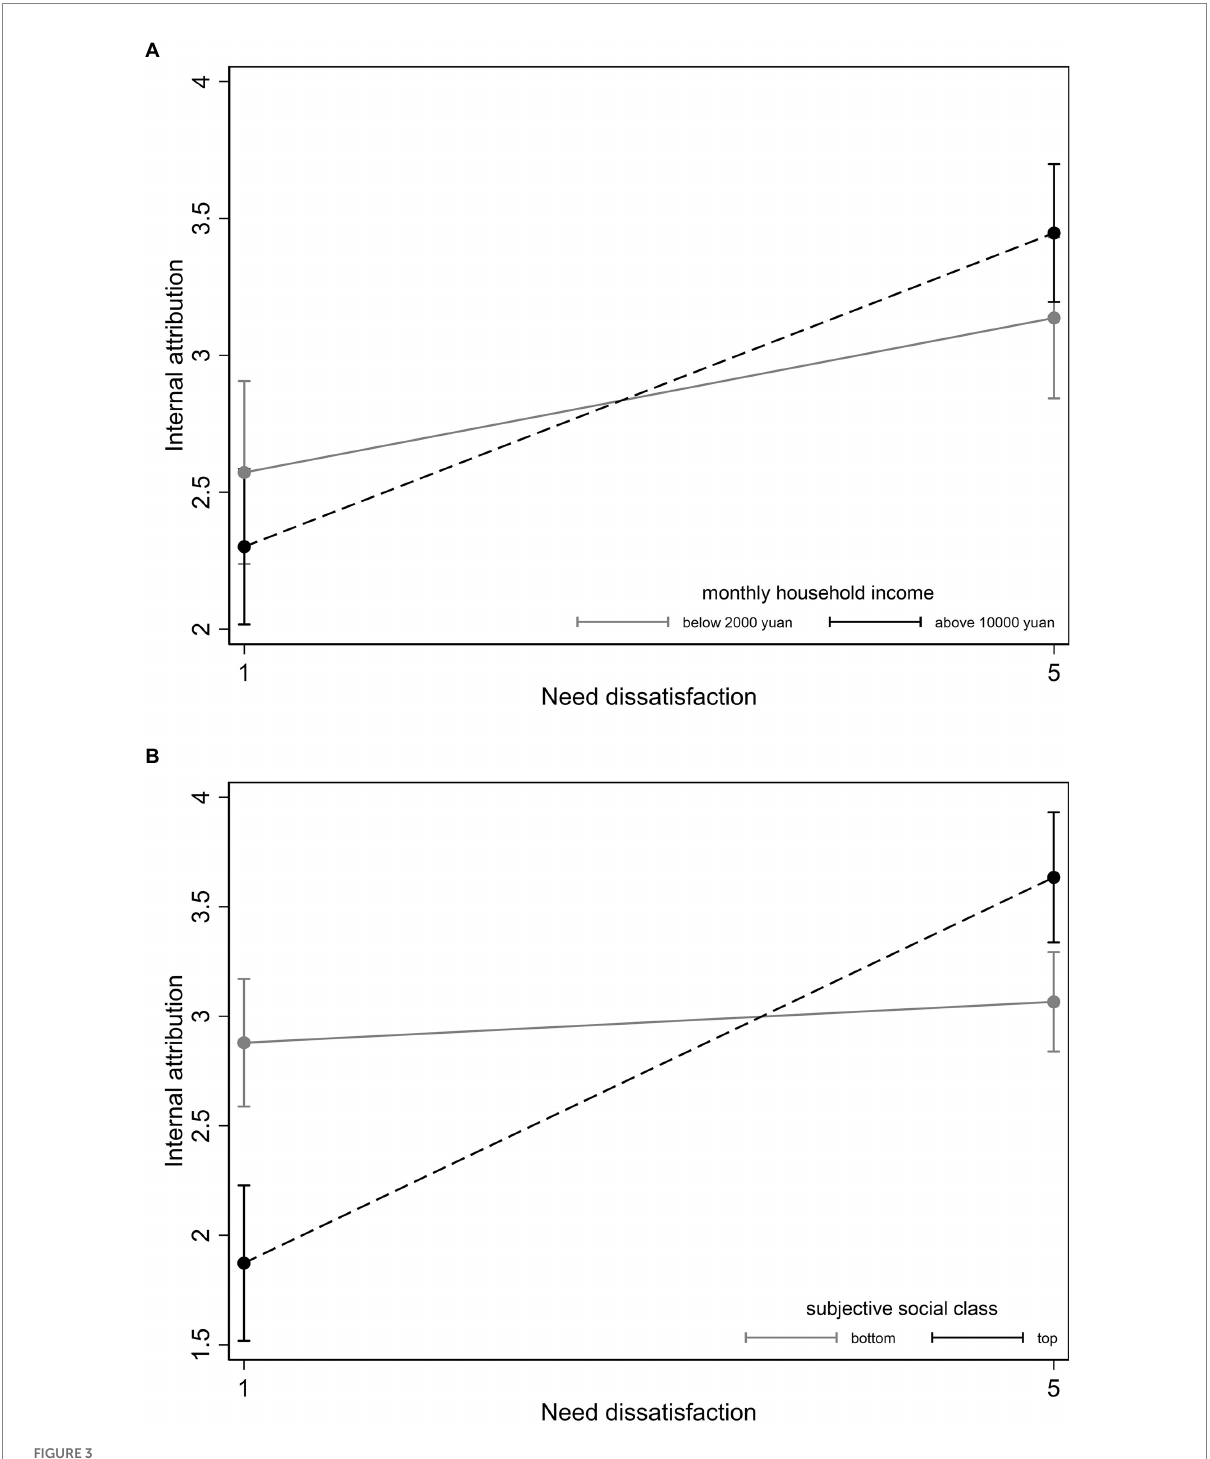
FIGURE 3 The moderation of household income (A) and subjective social class (B) between need dissatisfaction and internal